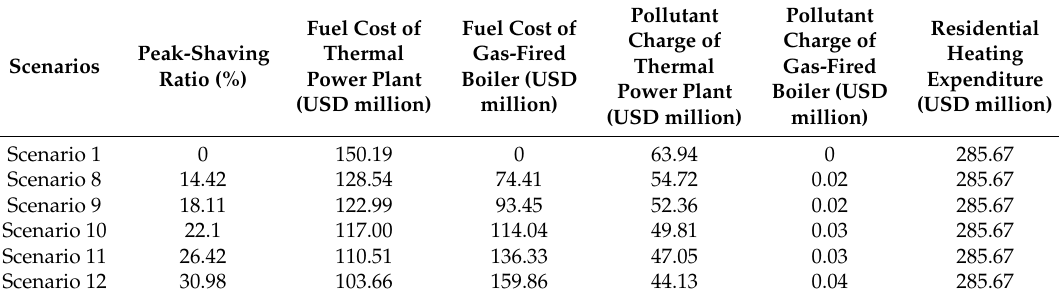
Table 4. Scenario analysis of heating cost under various peak-shaving